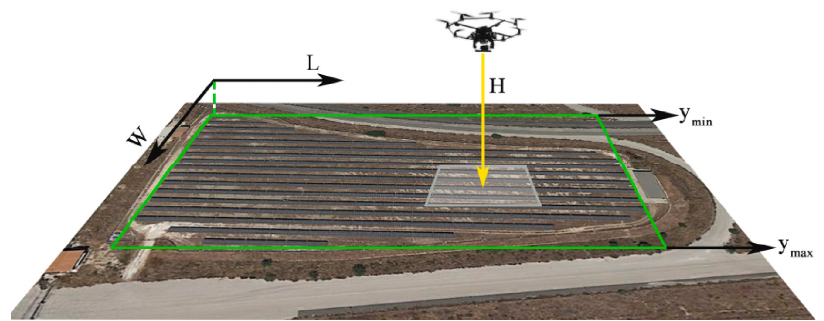
Figure 2. Path planning procedure of a PV power plant [51].